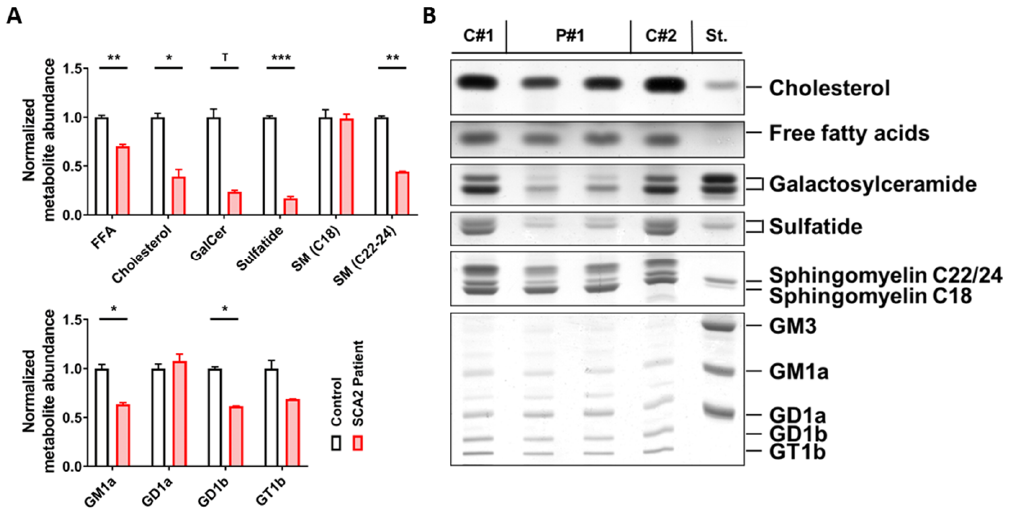
Figure 1. Cerebellar lipid profiles of one spinocerebellar ataxia type 2 (SCA2) patient. Technical duplicates (P#1 and P#2) were studied versus two age/sex-matched controls (C#1 and C#2) which were used to normalize all values. ( A ) Significant decreases in the abundance of free fatty acids, cholesterol, sulfatide, and very long-chain sphingomyelin (C22-24 SM) were observed in SCA2, and galactosylceramide (GalCer) appeared strongly reduced; for gangliosides, significant deficits in GM1a and GD1b were also observed. ( B ) Thin layer chromatography images of the lipid species analyzed in the adjacent bar graphs. Student’s t -tests were used with Welch’s correction; T p < 0.1, * p < 0.05, ** p < 0.01, *** p <